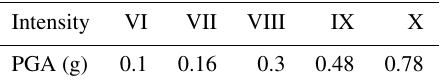
Table 5. The mean PGA values derived from intensity–PGA re- lations of Masonry_A based on the newly proposed approach (Sect.